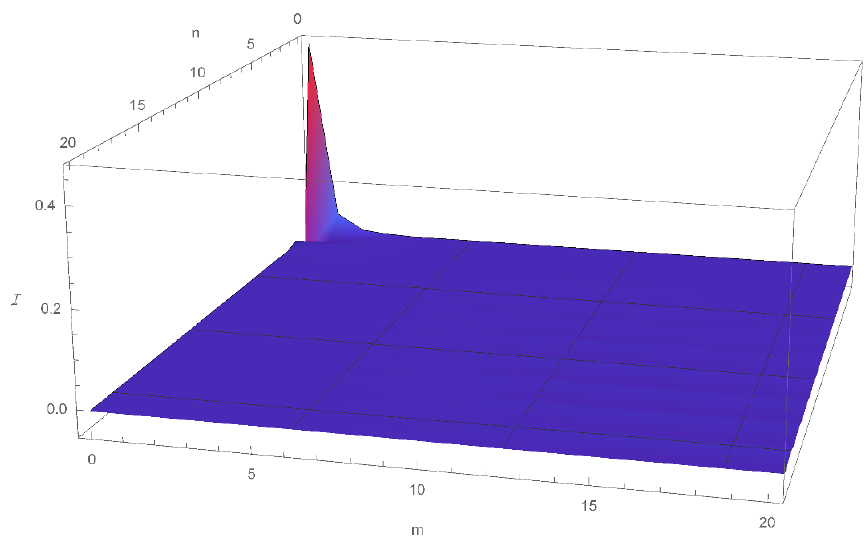
is given by the 2